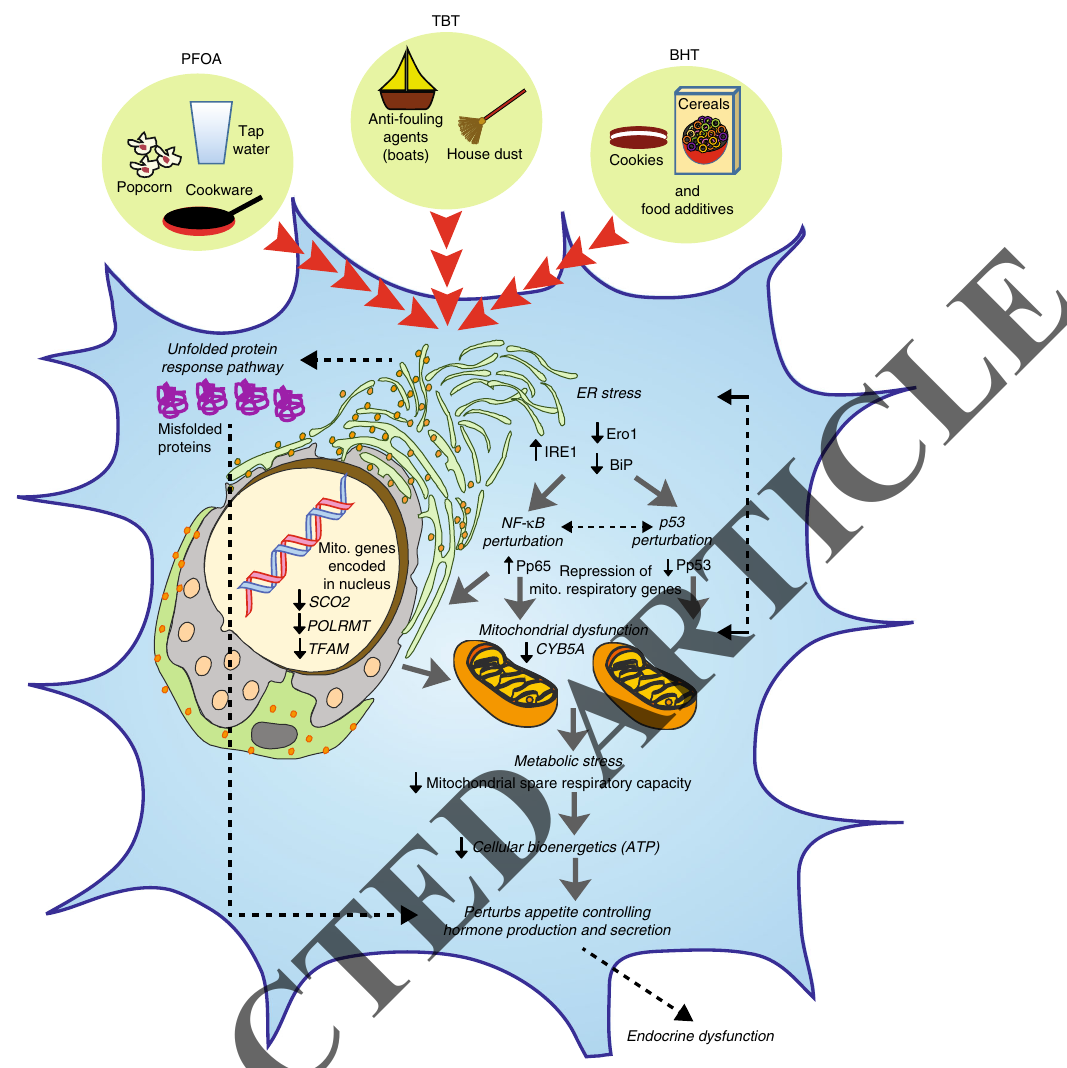
Fig. 7 Proposed model of EDC-mediated dysregulation in developing endocrine tissues. Developing endocrine cells when exposed to EDCs such as PFOA, TBT, and BHT trigger endoplasmic reticulum (ER) stress by increasing IRE1 and downregulation of Ero1 and BiP, which are known to induce an unfolded protein response (UPR) in a cell. This results in perturbation of NF- κ B (increased phosphorylation of p65) and p53 (decreased phosphorylation of p53 at Ser15) signaling in parallel. The subsequent metabolic stress is comprised of reduced transcription of both nuclear-encoded and mitochondrial-encoded respiratory genes, defective maximal respiration and mitochondrial spare respiratory, and a decrease in cellular bioenergetics/ATP levels. Intricate crosstalk between unhealthy mitochondria and ER may further lead to ER stress in a feedback loop and thereby exacerbate this mechanism. Overall, both accumulation of misfolded proteins as well as a decrease in ATP levels upon chronic exposure to low-dose of EDCs induces metabolic stress in an endocrine cell, thereby negatively impacting endocrine regulation because of abnormal production and secretion of gut and brain